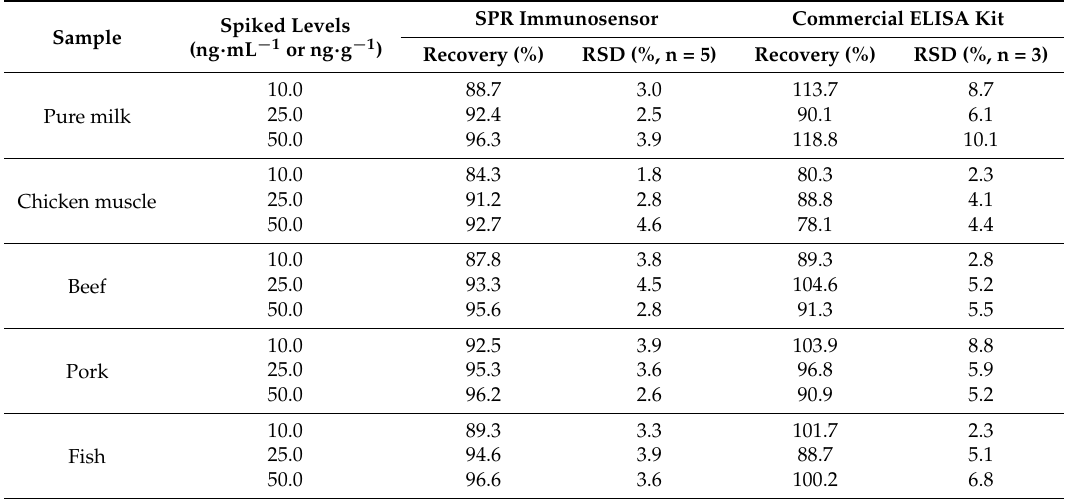
Table 1. Recoveries for ENRO in spiked food samples analyzed by the developed SPR immunosensor and the commercial ELISA kit.